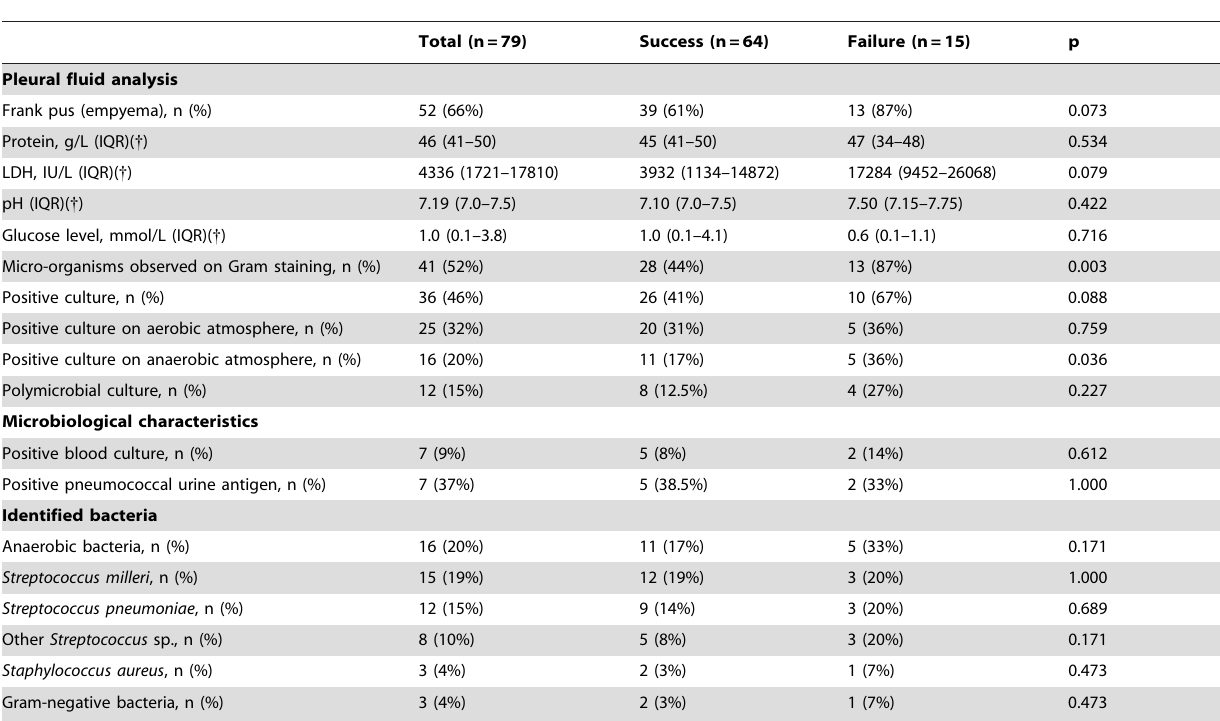
Table 2. Pleural fluid and microbiology characteristics (first thoracentesis).